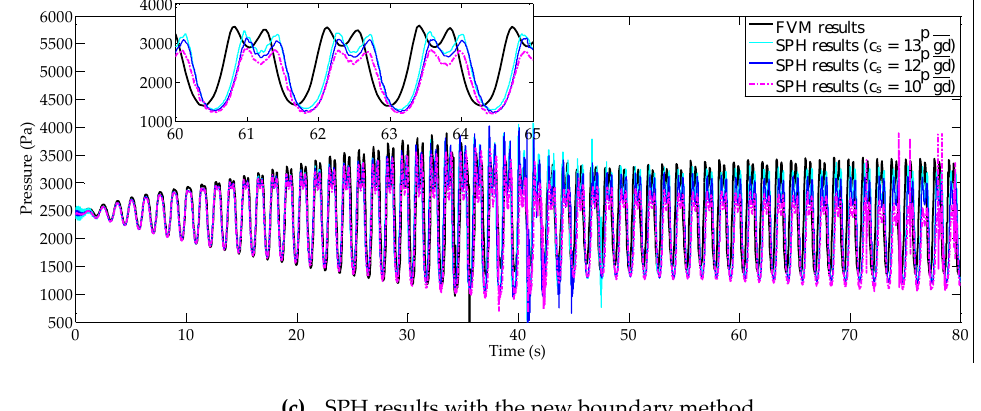
Figure 8. Pressure values at the pressure sensor obtained by the numerical simulations for Case 1: ( a ) SPH results with Chen’s boundary method; ( b ) SPH results with Shao’s boundary method; ( c ) SPH results with the new boundary method.